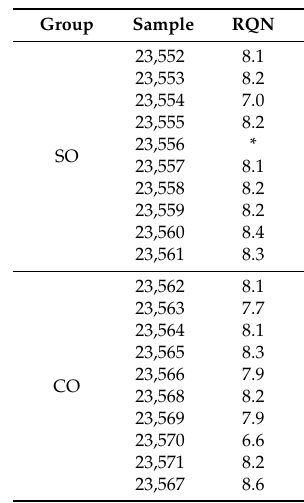
Table A1. RNA quality used in analysis.